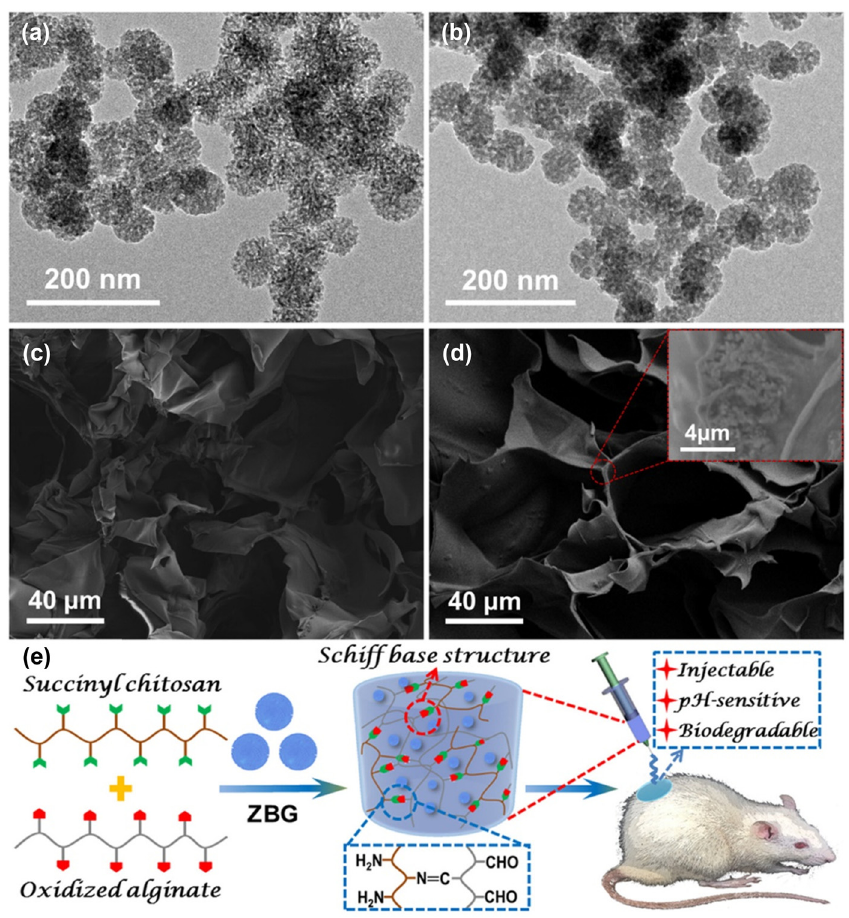
Figure 5: ( a and b ) TEM image for BG and ZBG. SEM images of ( c ) Gel and ( d ) Gel – ZBG composite hydrogels. ( e ) Schematic representation of the composite hydrogels as wound dressing for wound closure of SD rats [ 128 ]